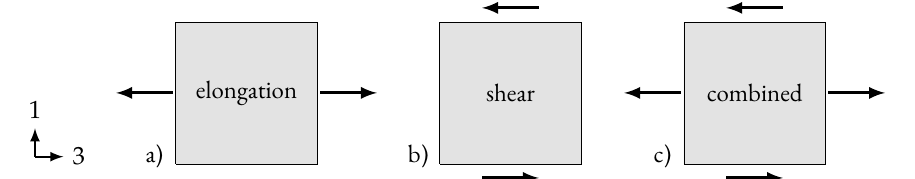
Figure 4. Schematic drawing of RVEs under deformation: ( a ) planar elongation, ( b ) simple shear, ( c ) combined shear and